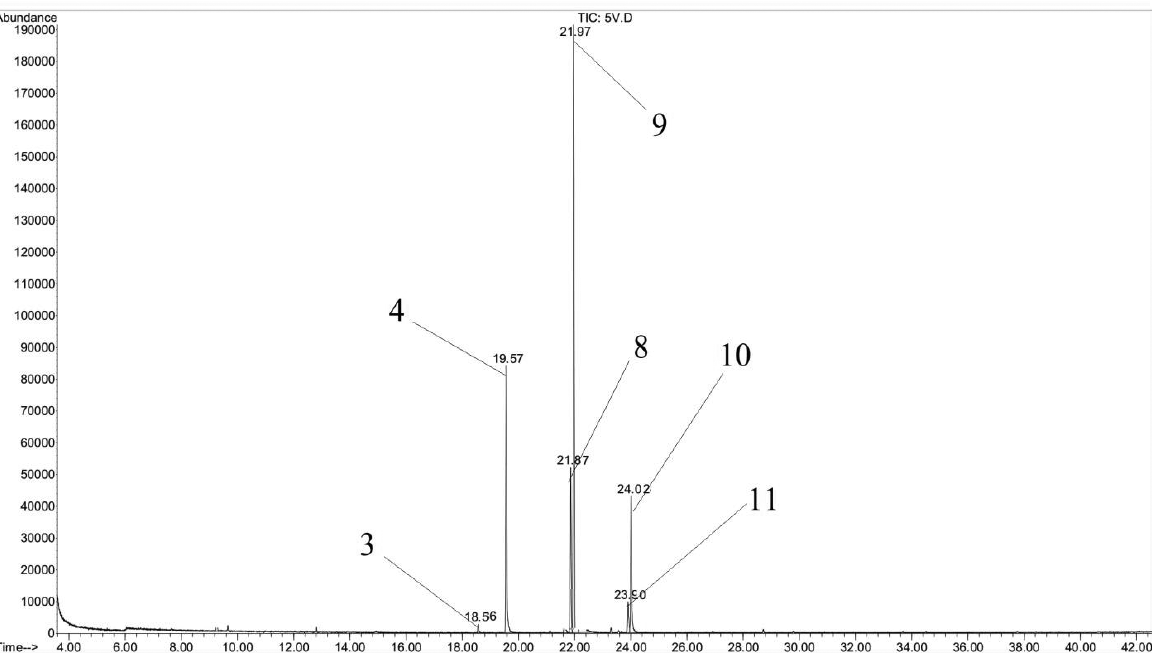
Figure 1. GC-MS chromatogram of free amino acids in the sample 1 of the plant mixture.